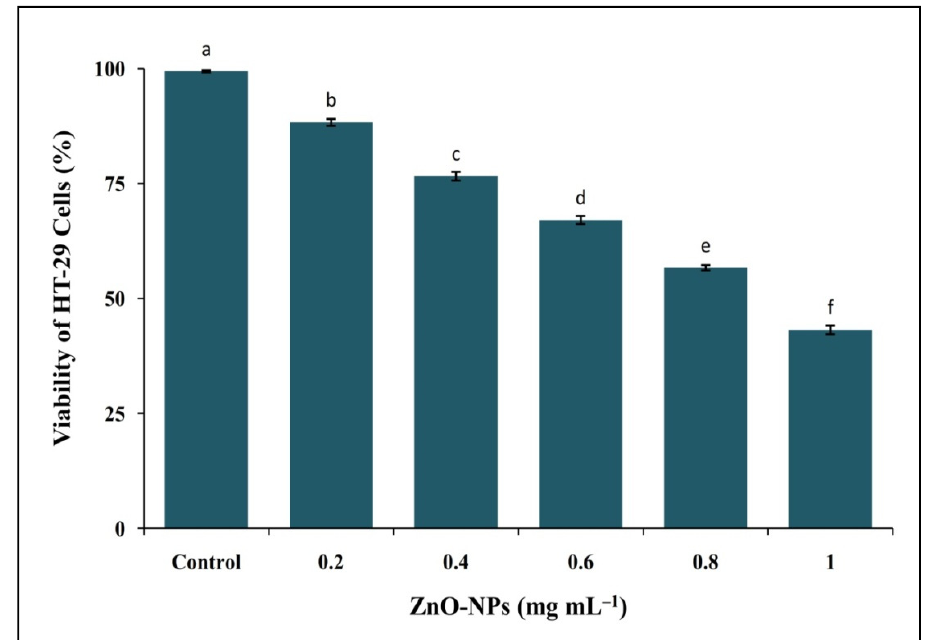
Figure 9. In vitro cytotoxicity study of phyto-fabricated ZnO-NPs from I. obscura aqueous leaf extract against HT-29 cell lines by MTT assay. Each value is the mean for three replicates (n = 3) and bars sharing the same letters are not significantly different ( p ≤ 0.05) according to Tukey’s HSD. The vertical bar indicates the standard error.